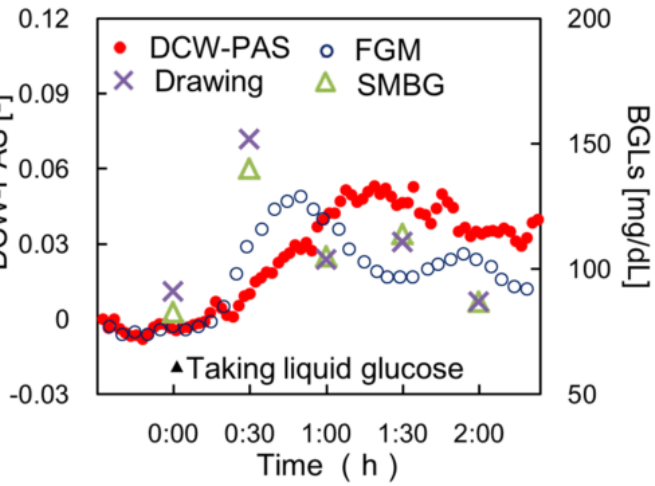
Figure 3. Typical comparison between DCW-PAS signals and the blood glucose levels of volunteers. The closed circles, open circles, triangles, and crosses in the figure are the results from the DCW-PAS, FGM, SMBG, and drawn blood, respectively. Reprinted from [21] .